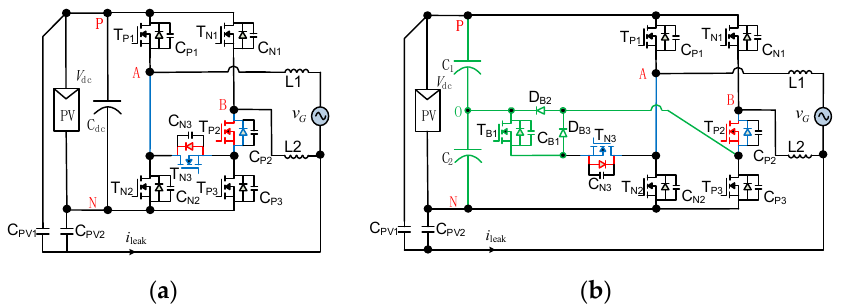
Figure 27. Topology H6 without / with NPC cell under USPWM. ( a ) R5; ( b ) R5S2-2 (new).